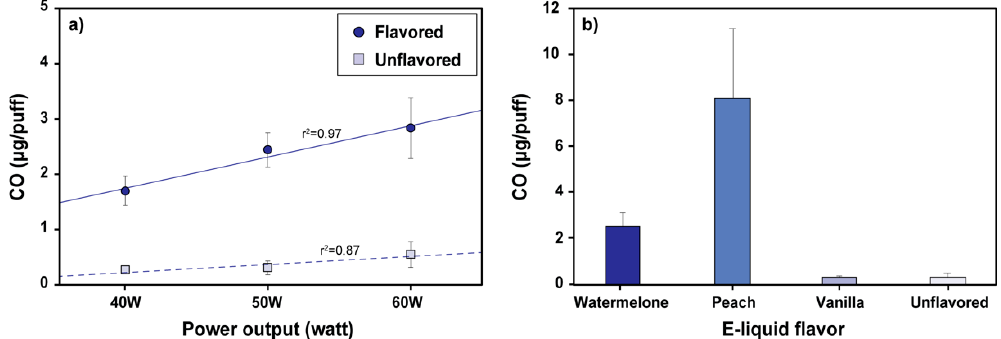
Figure 4. Effect of (a) e-cigarette power output and (b) e-liquid flavor on CO emissions. Power output effects were tested using 40 mL, 4-sec puffs with a 30-sec inter-puff interval with strawberry- watermelon flavored and unflavored e-liquids. Emissions of different flavor e-liquids were tested with the same puff parameters at 50-watt power output. Error bars represent standard deviation of three independent measurements.